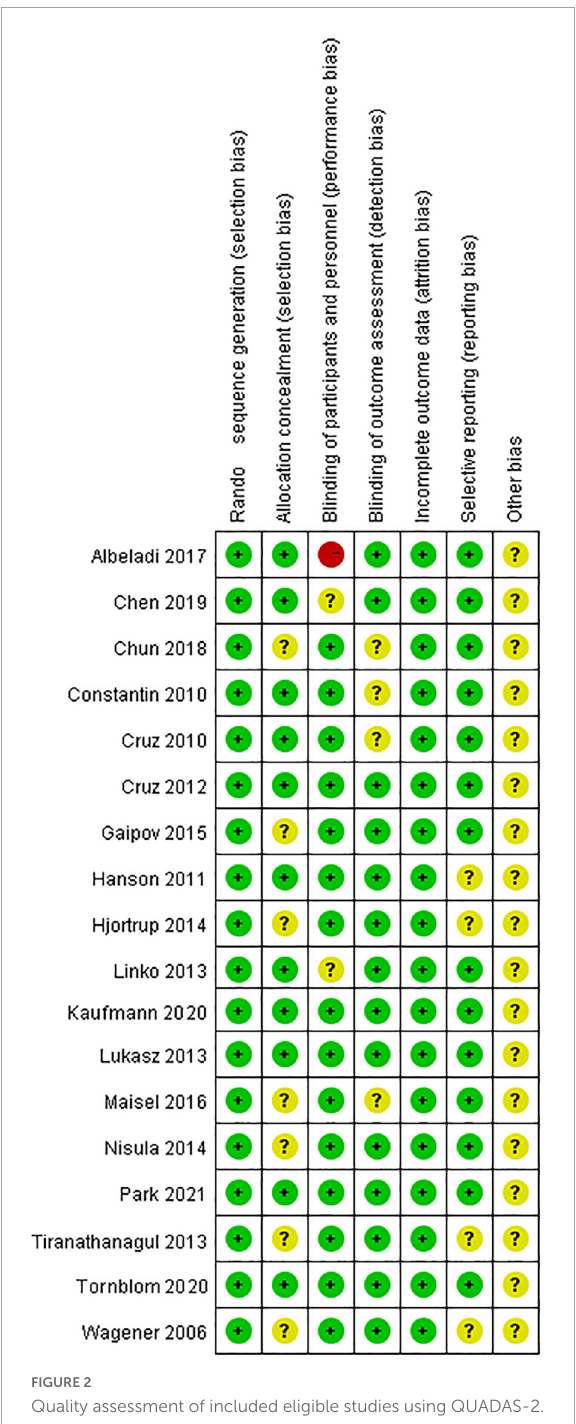
the predictive value of NGAL for AKI requiring RRT from plasma/serum and urine samples is shown in Figure 4 . For summary performance estimates, the pooled sensitivity and specificity with corresponding 95% CI were 0.75 (95% CI: 0.68– 0.81) and 0.76 (95% CI: 0.70–0.81), respectively. The pooled